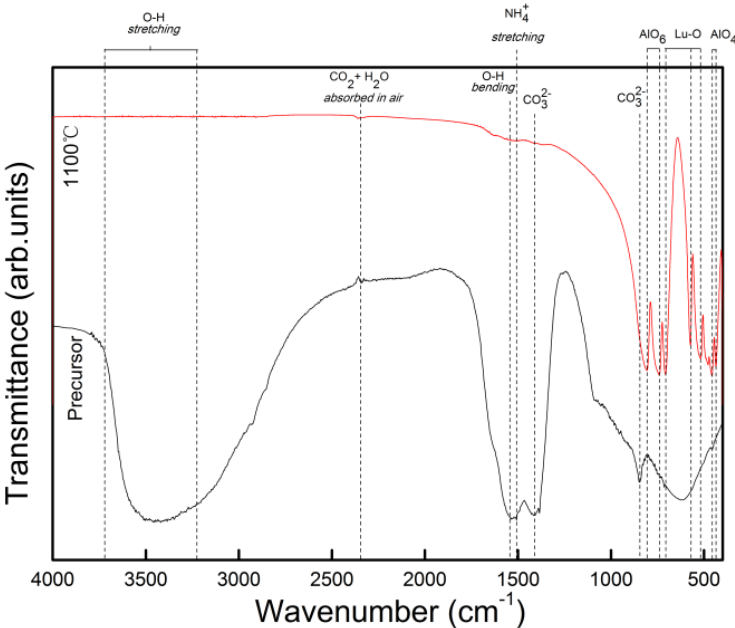
Figure 6. FTIR spectra of the precursor and resultant powder calcined at 1100 °C for 3 h of S7.